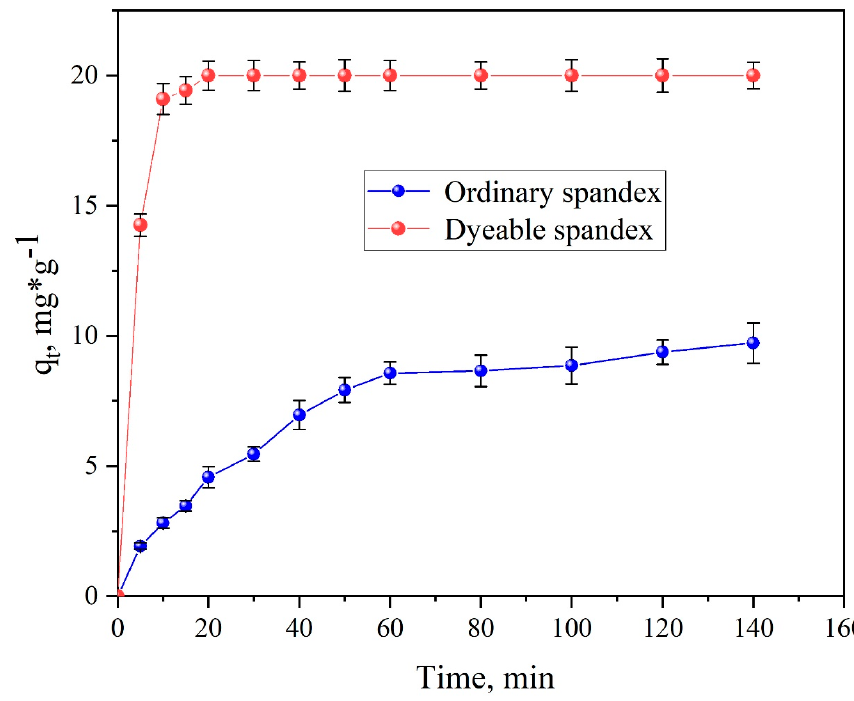
Figure 8. Dyeing rate curves of neutral red G on two kinds of spandex. Calculation of Equilibrium Adsorption Capacity, Time of Half Dyeing, and Rate Con-